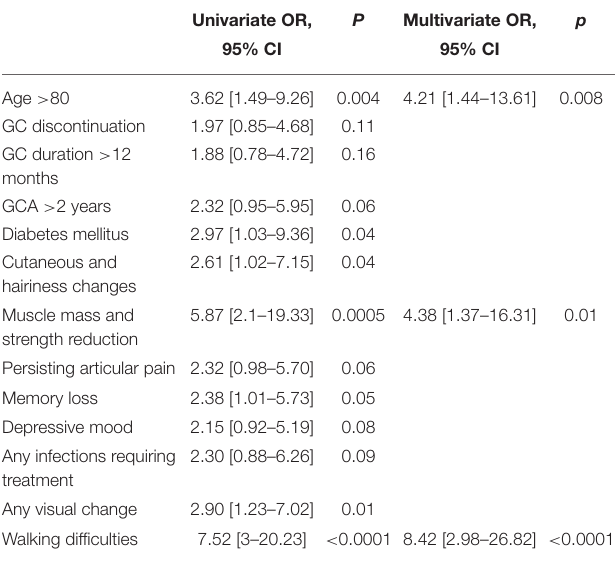
TABLE 3 | Comparison of GCA patients according to the felt severity of mental disability as assessed by the SF-12 survey. None-to-slight